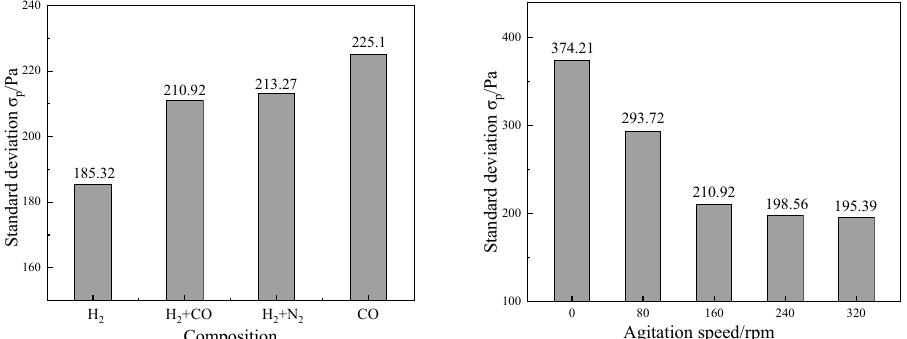
Figure 3. Standard deviation of pressure drop in the fluidized bed. ( a ) Different gas compositions. ( b ) Different agitation